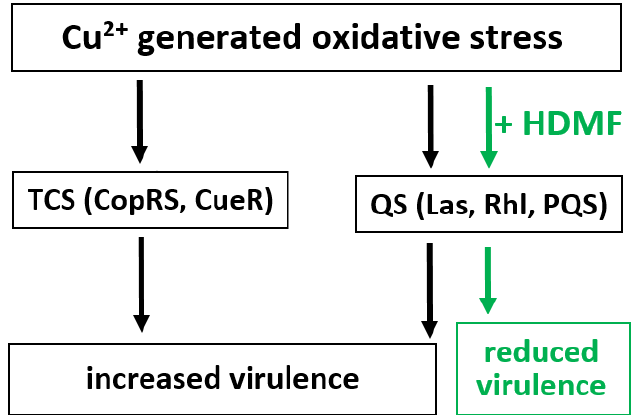
Figure 8. The proposed model of anti-virulent action of HDMF in combination with Cu 2+ . The cupric ions generated stress induces the neutralizing mechanisms regulated by TCS and QS systems, leading to increased virulence of the bacterium. In contrast, HDMF interferes with QS molecules reducing the expression of virulence determinants.